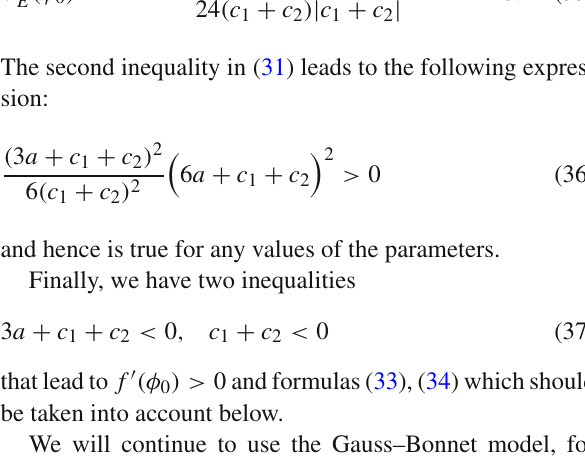
are true [40]. The range of the Lagrangian parameters can